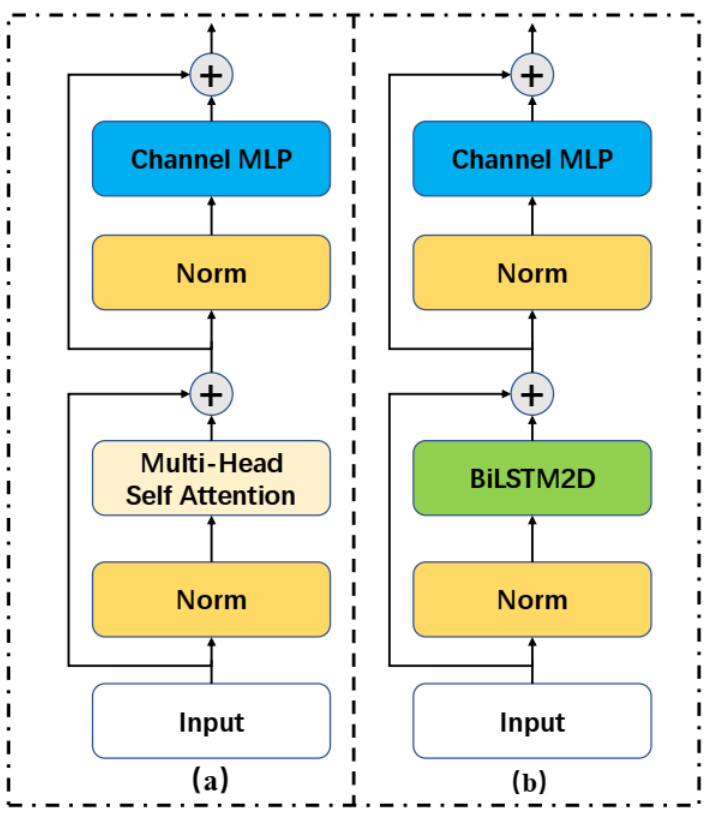
Figure 3. ( a ) The Transformer block consists of multi-head attention ( b ) The Sequencer module consists of BiLSTM2D.